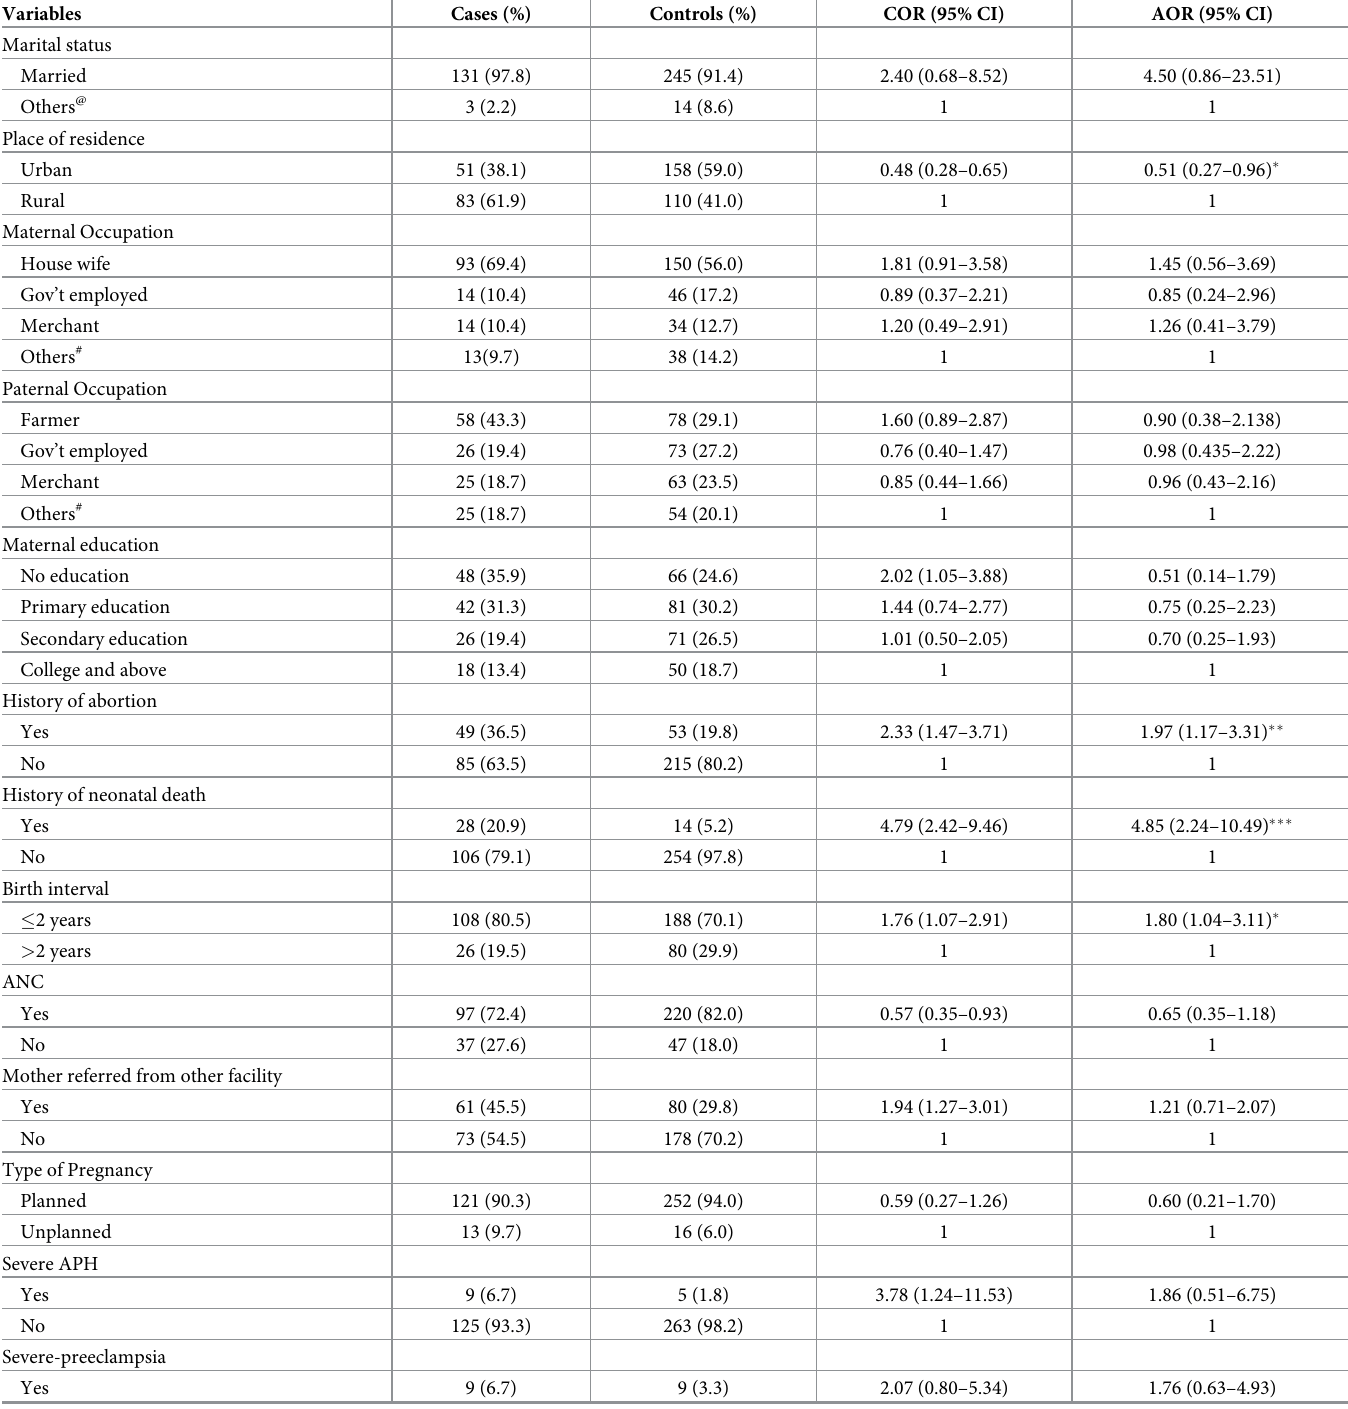
Table 4. Multivariable logistic regression analysis on determinants of neonatal near miss among mothers giving live births at Guji and Borena Zones General Hos- pitals, Southern, Ethiopia,